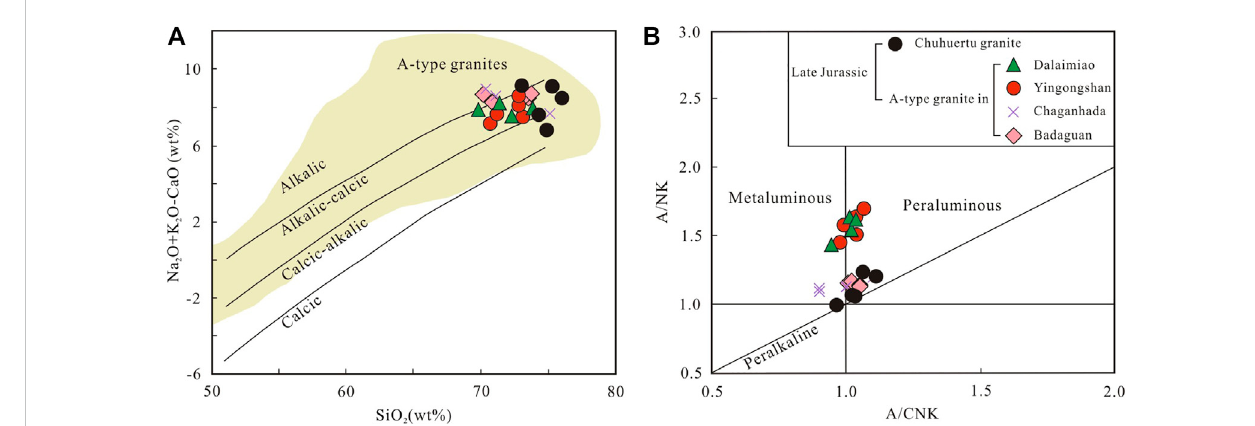
FIGURE 4 (A) SiO 2 versus Na 2 O + K 2 O — CaO diagram (adapted from Frost and Frost, 2008) and (B) A/CNK versus A/NK diagram (adapted from Maniar and Piccoli, 1989) for the granite in Chuhuertu. Data sources: A-type granite in Dalaimiao (Xue et al., 2015), Yingongshan (Gao et al., 2021), Chaganhada (Gao et al., 2022), and Badaguan (Tang et al., 2015).